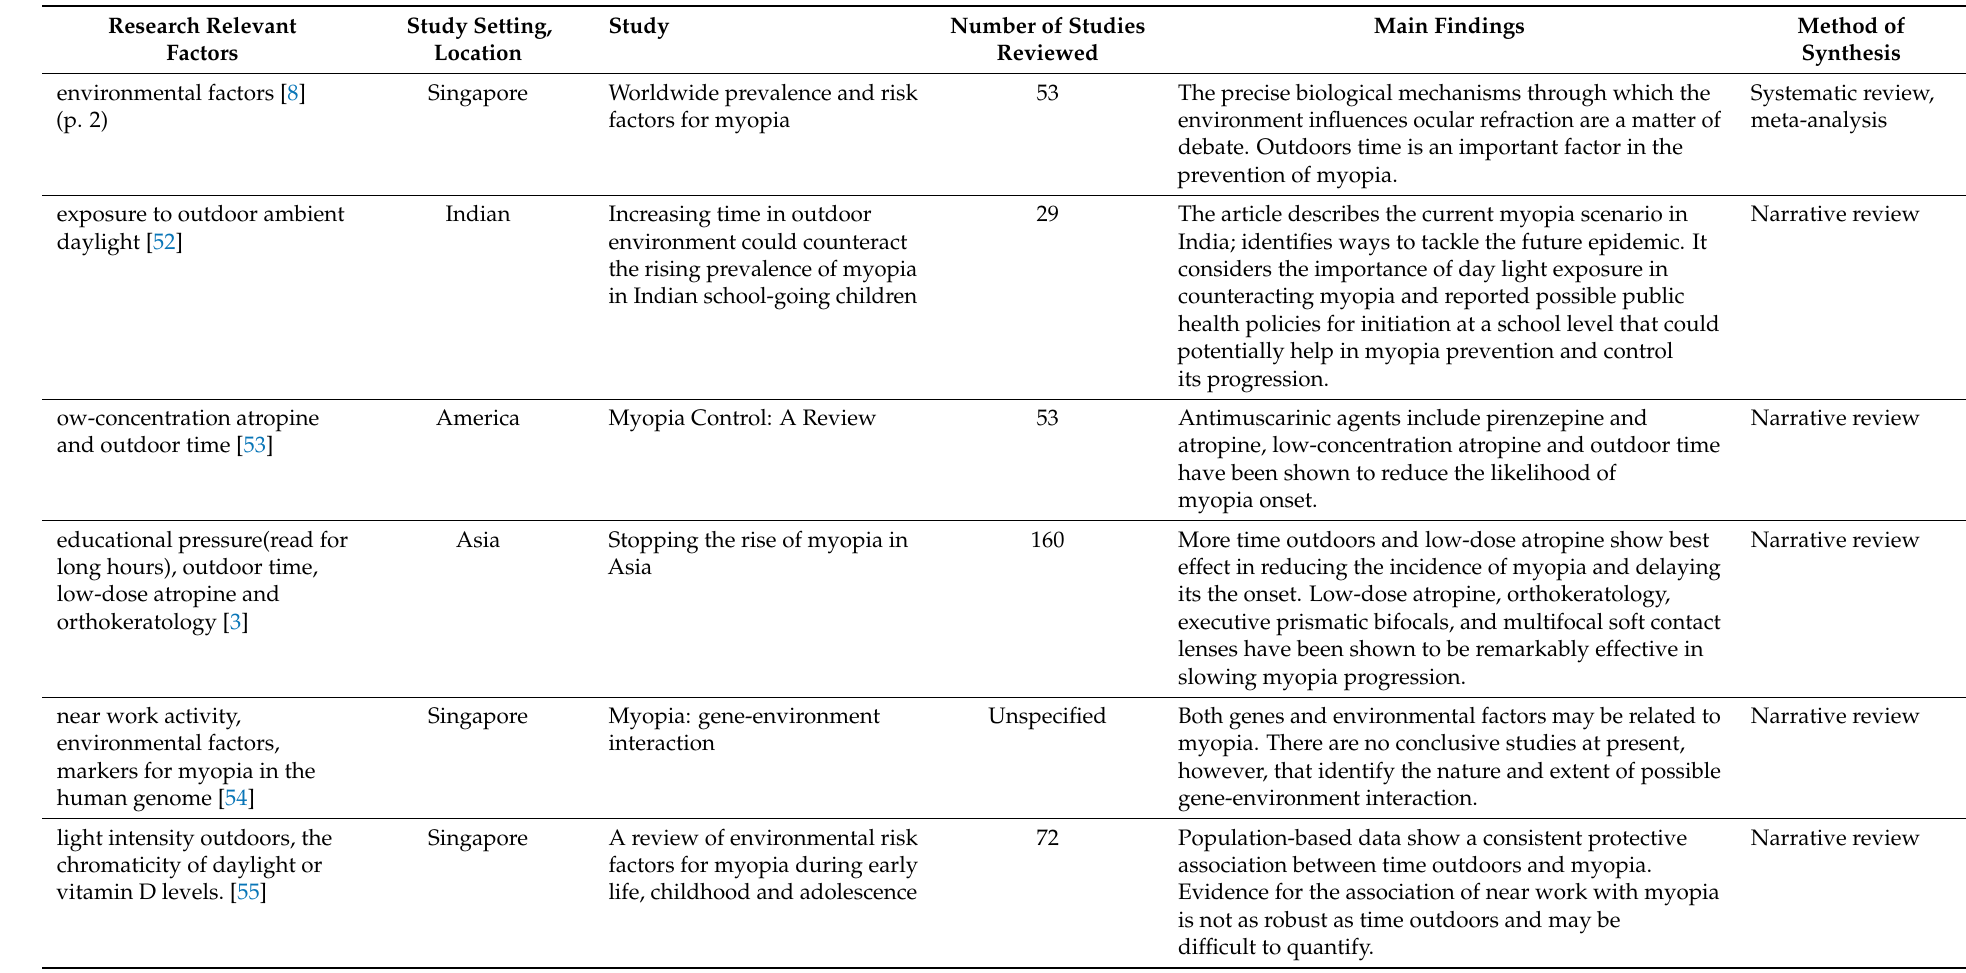
Table 2. Reviews of Visual Health Risk